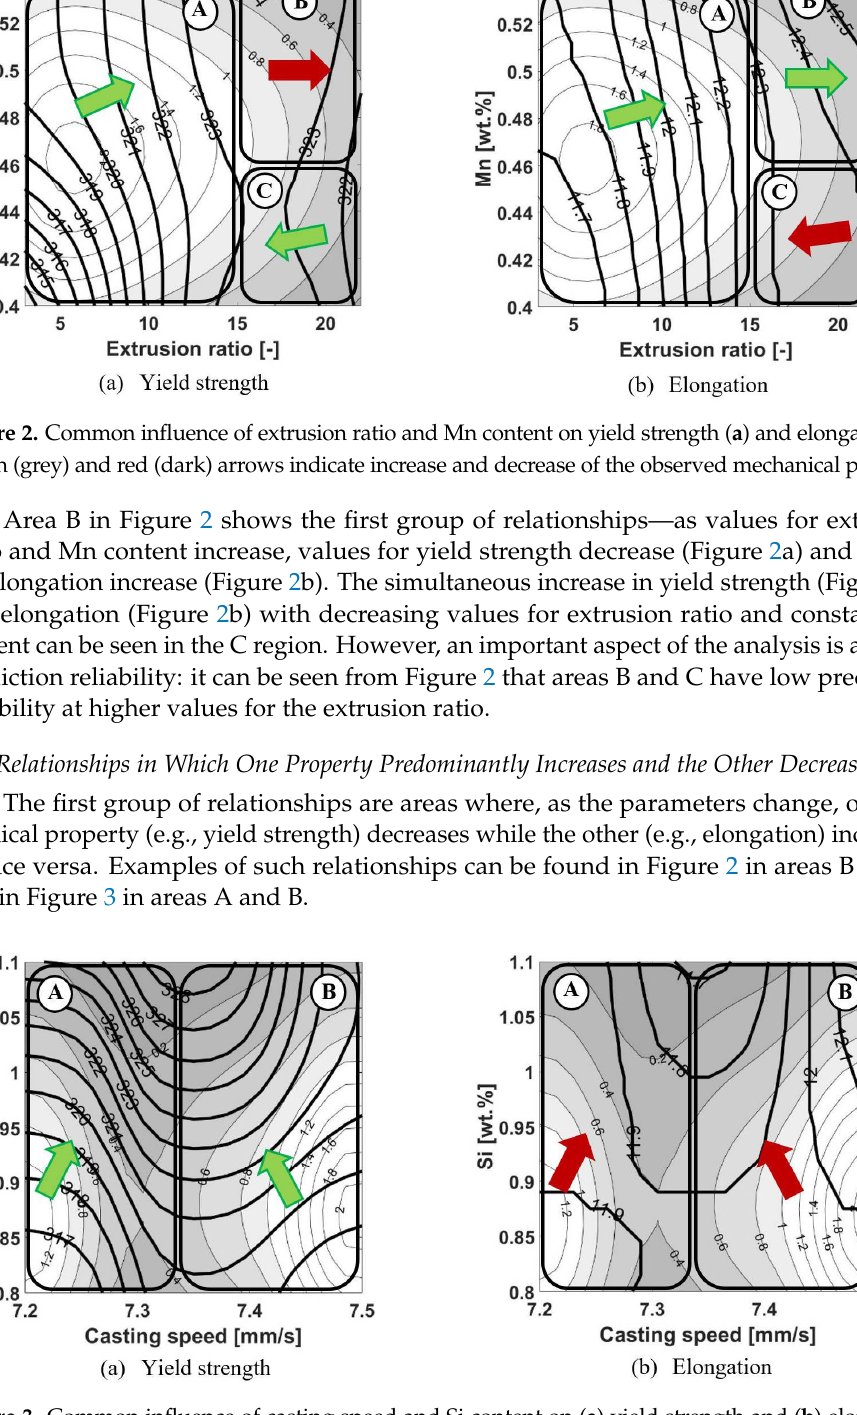
Figure 3. Common influence of casting speed and Si content on ( a ) yield strength and ( b ) elongation. Green (grey) and red (dark) arrows indicate increase and decrease of the observed mechanical prop- erty.